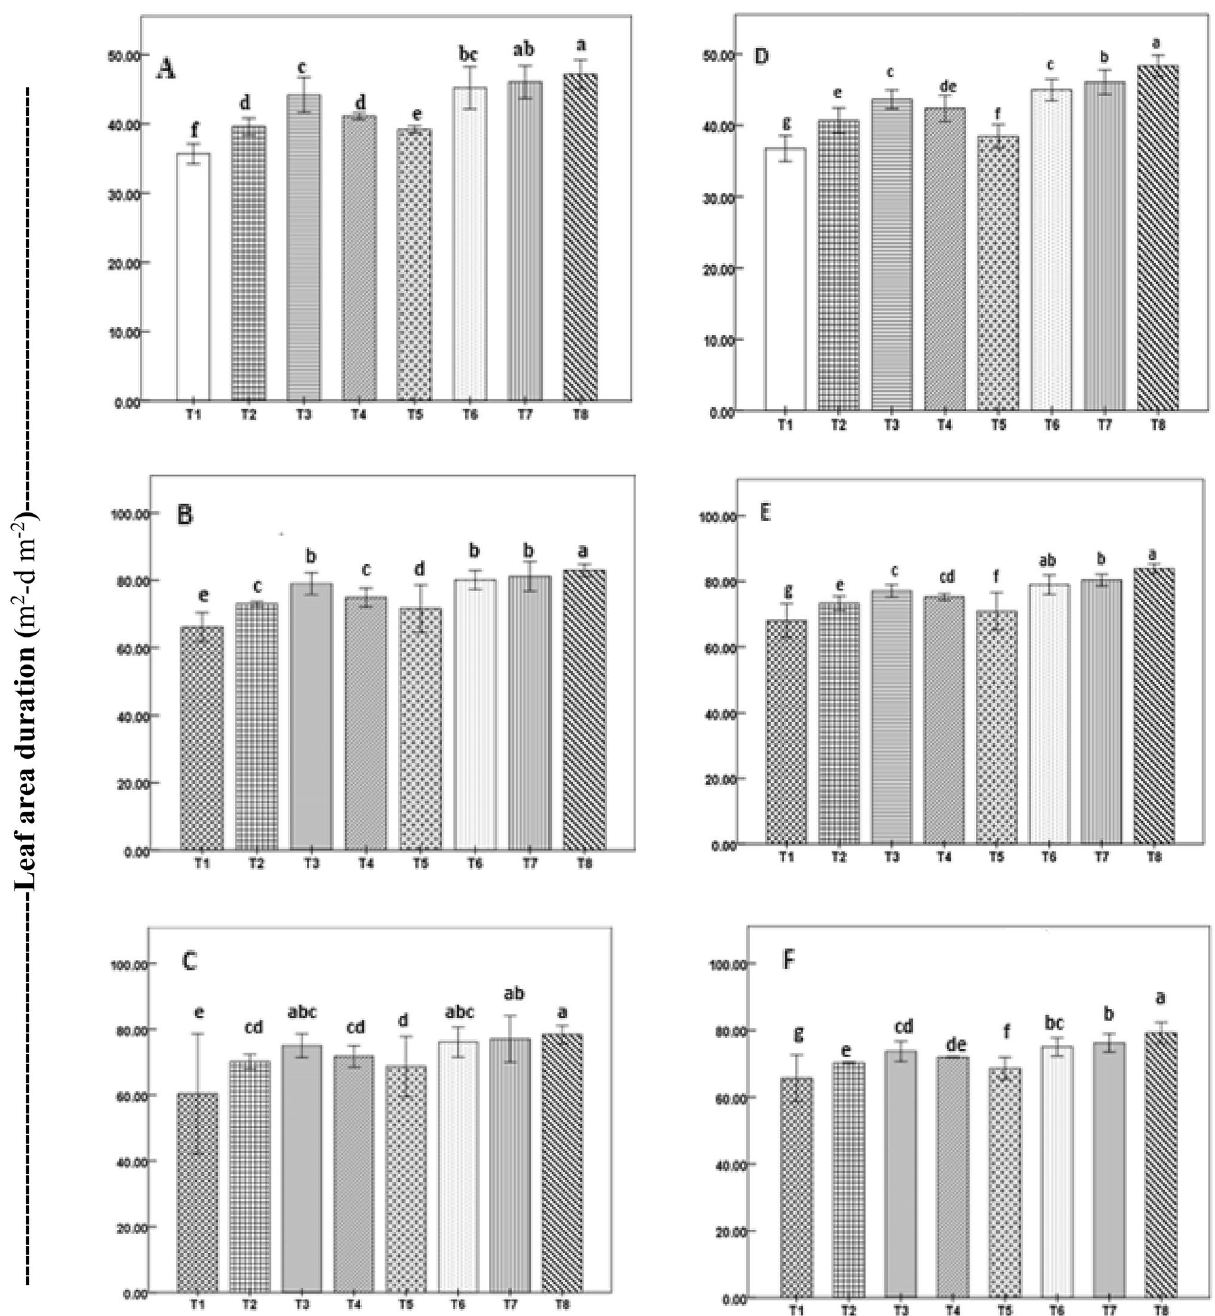
Figure 2. Leaf area duration of direct-seeded rice plants during vegetative ( A , D ), reproductive ( B , E ), and ripening ( C , F ) stages as affected by seed priming in a field experiment in 2019 ( A – C ) and 2020 ( D – F ). Treatment bars with different letters represent significant differences (P < 0.05) between means. Vertical lines with caps are ± standard error of the mean of treatments. Treatments details are given in Table